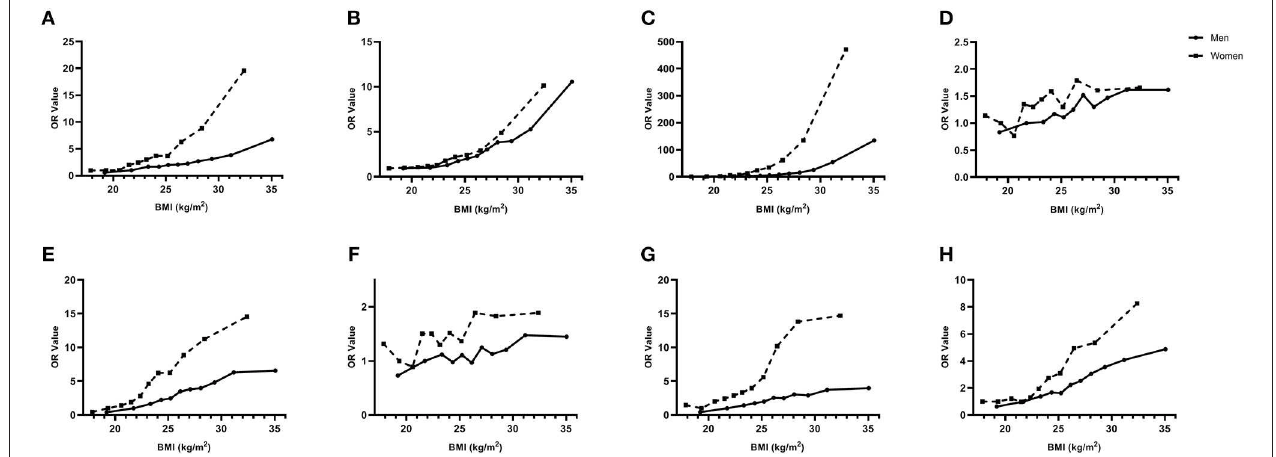
FIGURE 2 | Age-adjusted odds ratio for the association between Body Mass Index (BMI) and health-related indicators. (A) Hyperglycemia; (B) Hypertension; (C) Non-alcoholic fatty liver disease; (D) Hypercholesterolemia; (E) Hypertriglyceridemia; (F) LDL-C Hyperlipidemia; (G) HDL-C Hypolipidemia; (H) Hyperuricemia. BMI was divided into 11 categories according to